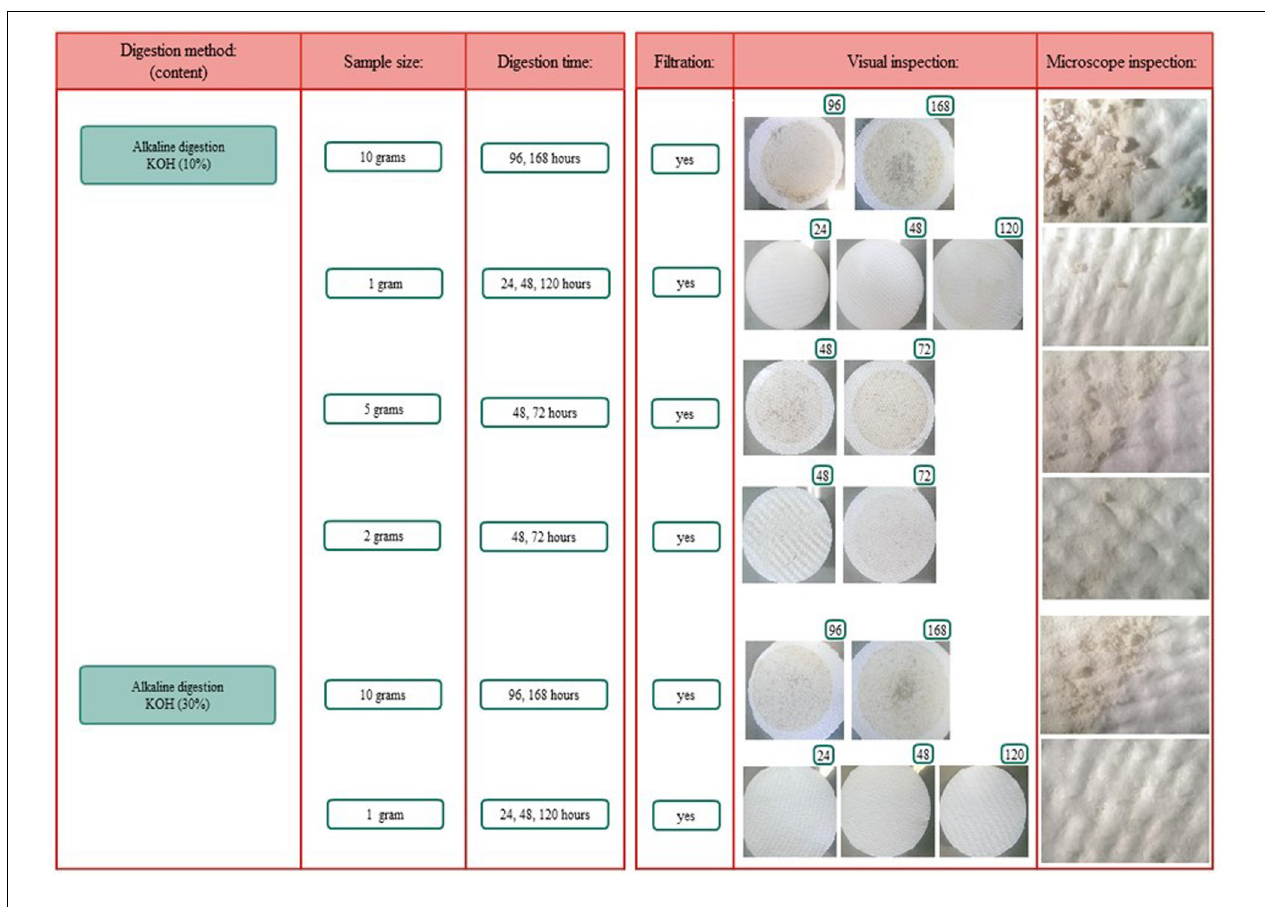
FIGURE 6 | Alkaline digestion test results.